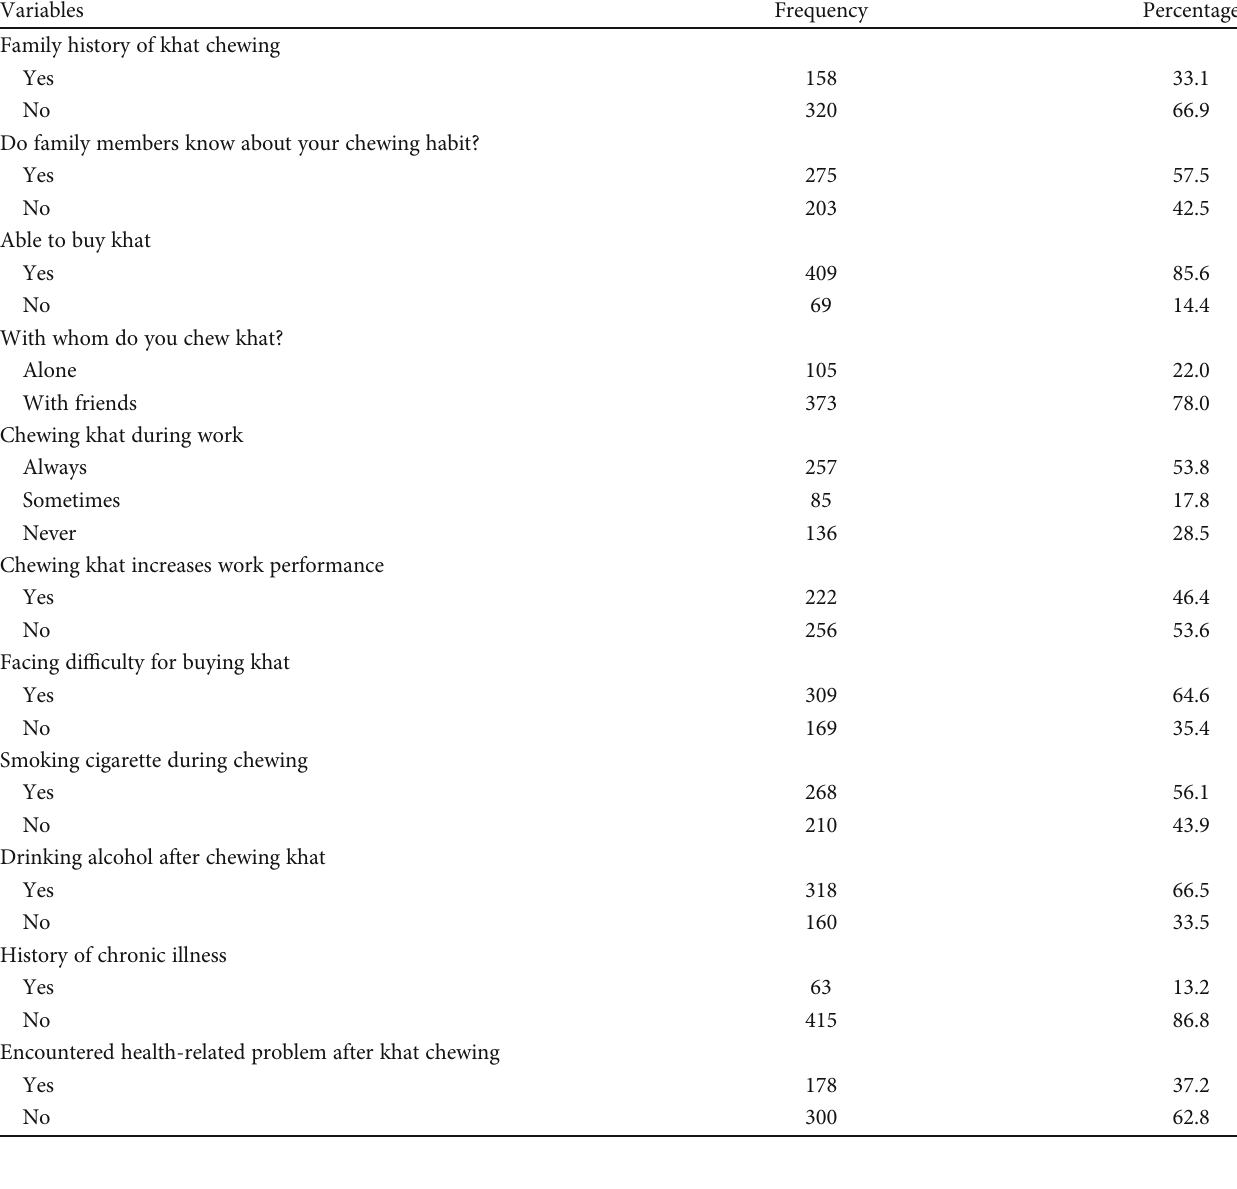
Table 3: Khat-related behavioral factors among khat chewers in Amhara region, 2019 ( N = 478 ).